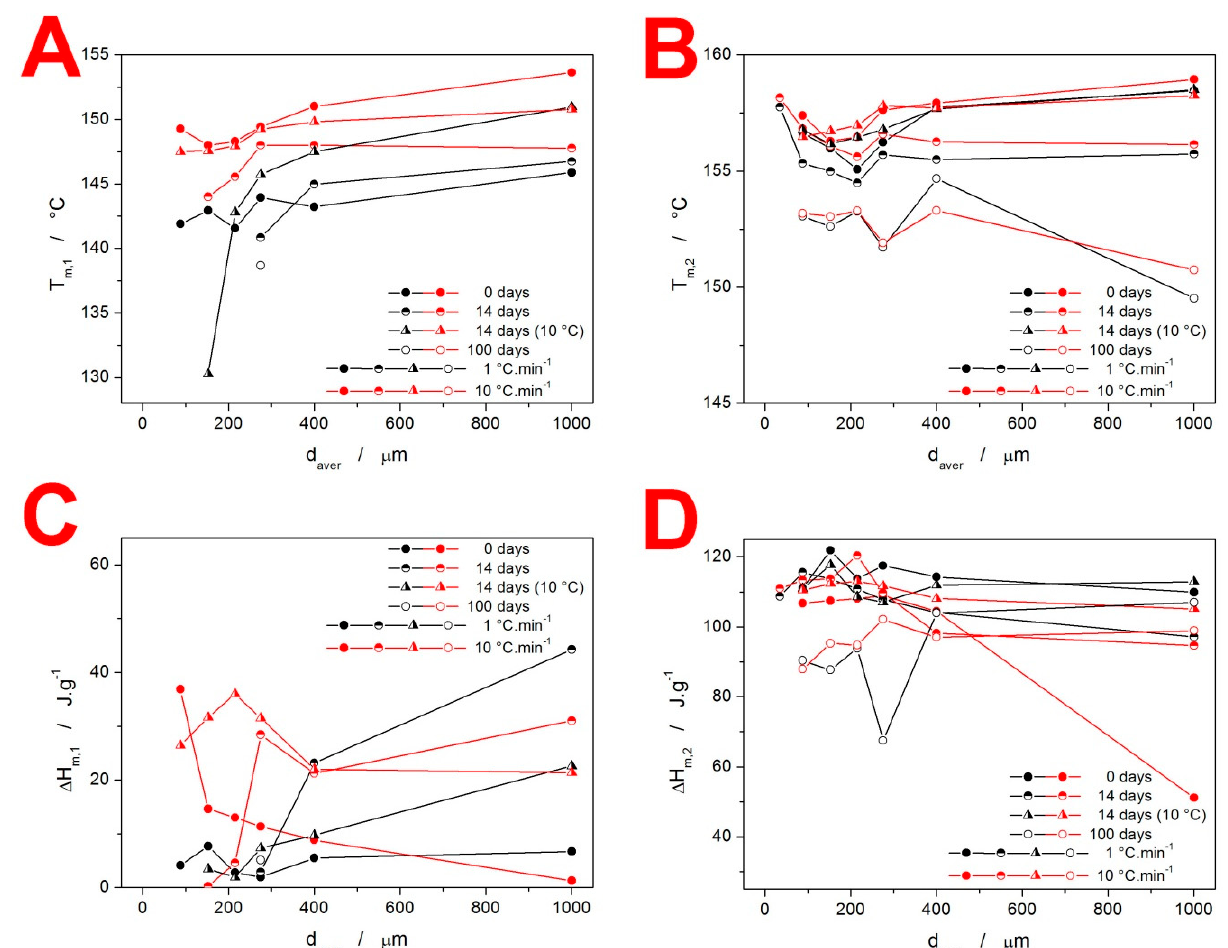
Figure 6. Graphs showing T m,1, ( A ) T m,2, ( B ) and the corresponding melting enthalpies Δ H m,1 ( C ) and Δ H m,2 ( D ) obtained at chosen q + for the IMC powders stored under different conditions. and ∆ H m,2 ( D ) obtained at chosen q + for the IMC powders stored under different